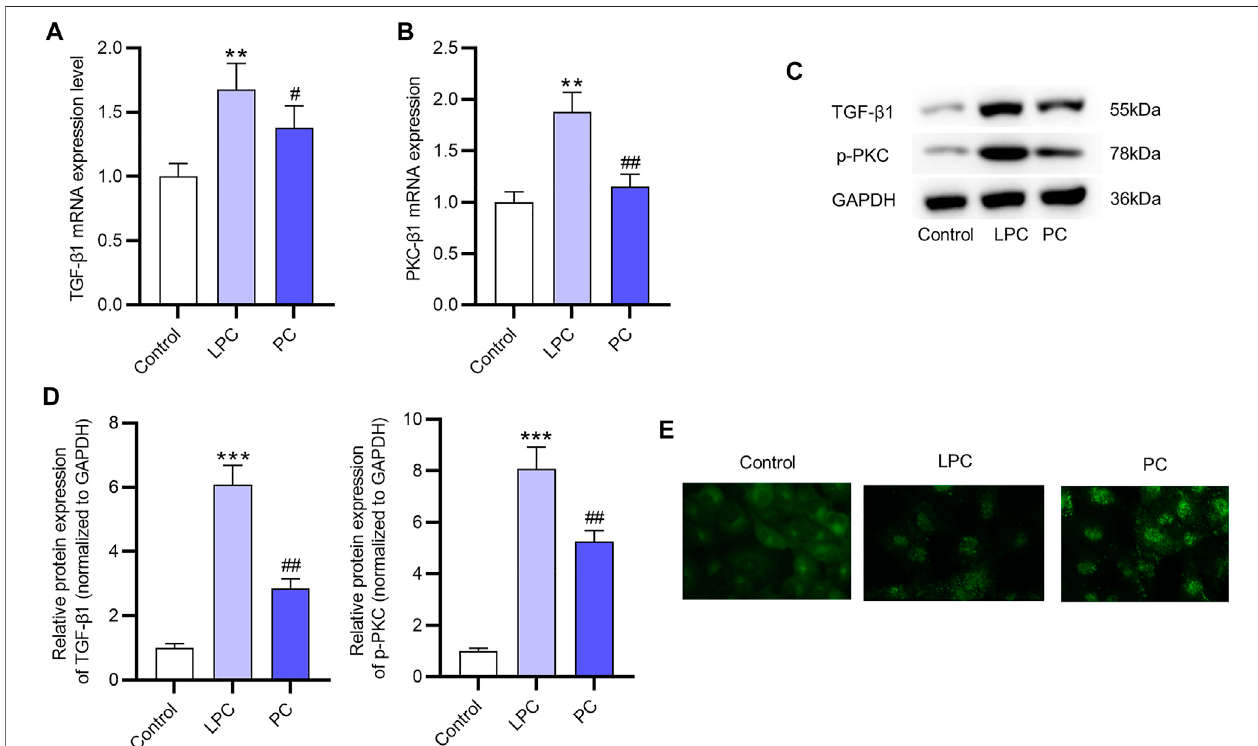
FIGURE 5 | The promotive effect of LPC on the activation of the PKC signaling in EPCs. (A,B) The mRNA expression of PKC- β 1 and TGF- β 1 after LPC or PC treatmentinEPCsweremeasuredbyRT-qPCR. (C,D) Theproteinlevelsofp-PKCandTGF- β 1wereinEPCstreatedwithLPCorPCwereaccessedusingwesternblot. (E) Immuno fl uorescence staining was used to determine the location of PKC- β 1 after the LPC or PC treatment in EPCs ( Figure 5D ). ** p < 0.01, *** p < 0.001 compared with the control, # p < 0.05, ## p < 0.01 compared with the LPC